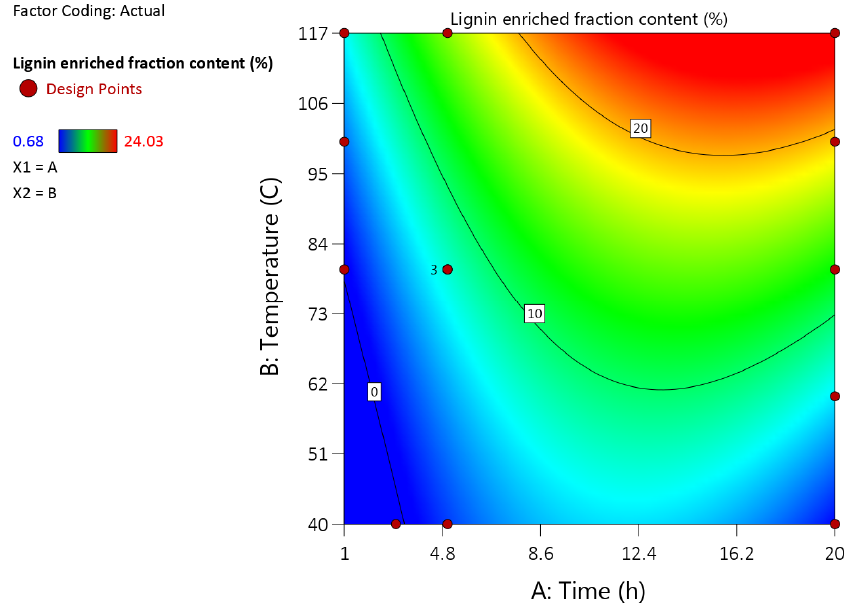
Figure 3. The gravimetric isolated yield of precipitated lignin-enriched fractions in dependence of temperature and process time. Table 2. Precipitated lignin-enriched fraction and insoluble cellulose-enriched fractions yields on dry matter of extracted bark depending on used solvent system.